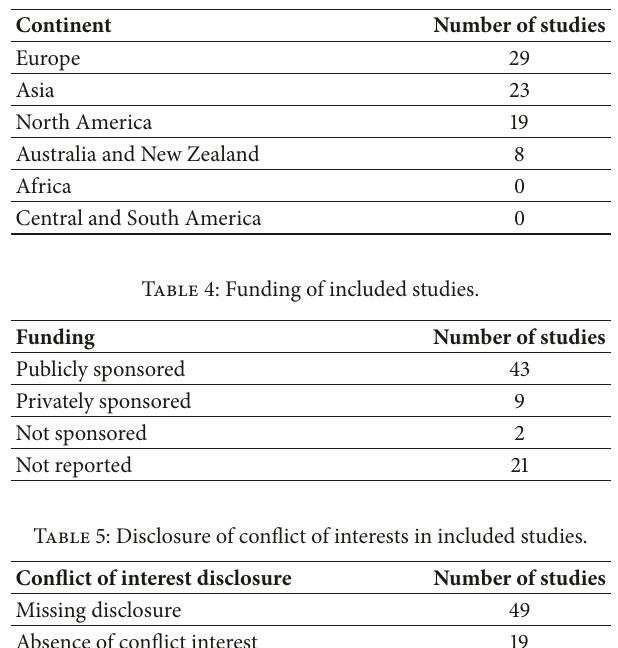
Table 2: Years of publication of included studies. Table 3: Continents of included studies.